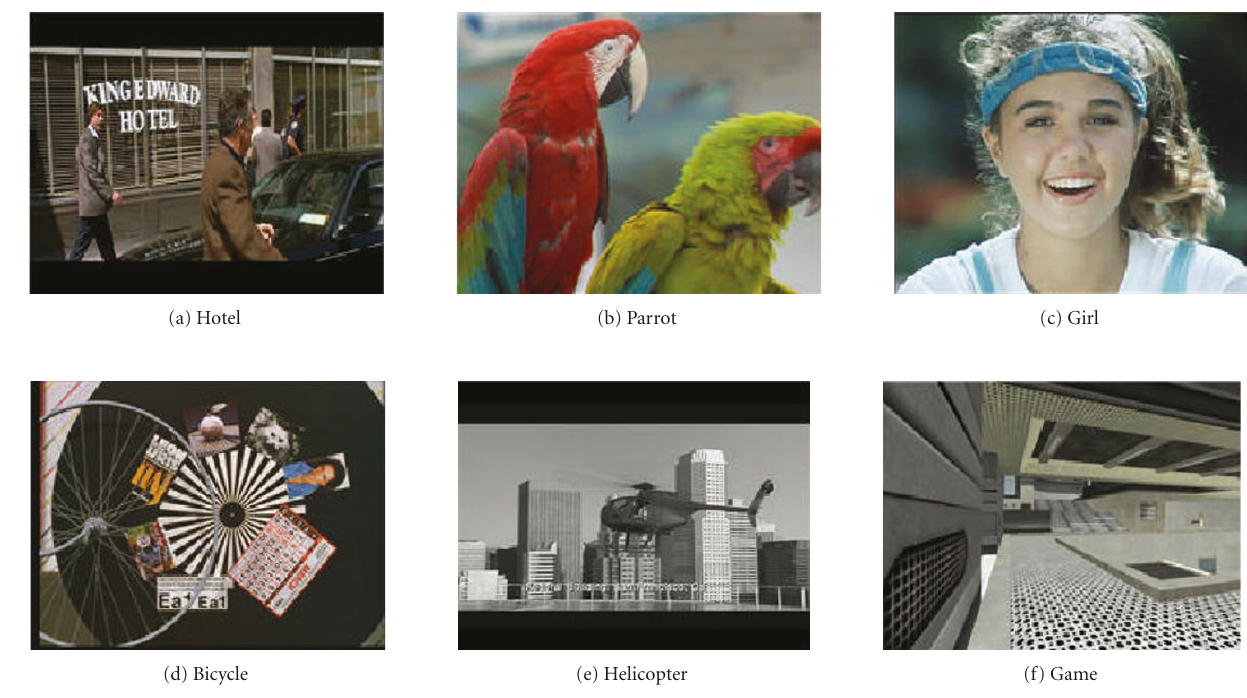
Figure 5: Snapshots of test sequences for experiments.